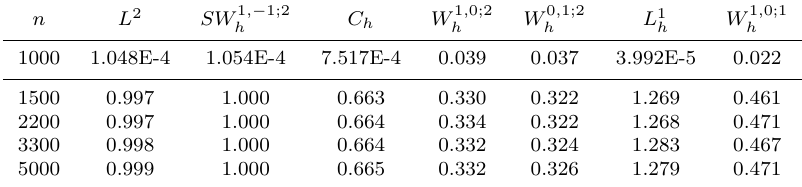
Table 18. Practical errors and error orders in Example C − 1 / 2 , 1